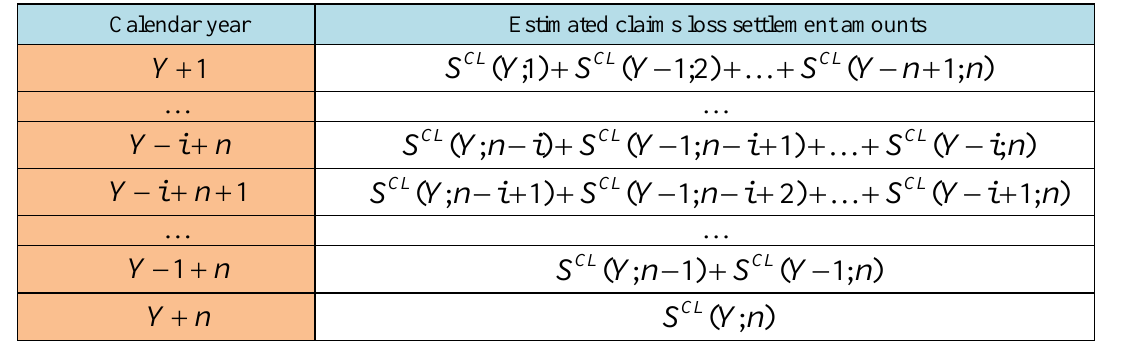
Fig. 5. Allocating estimated future claims loss settlements to future calendar years.